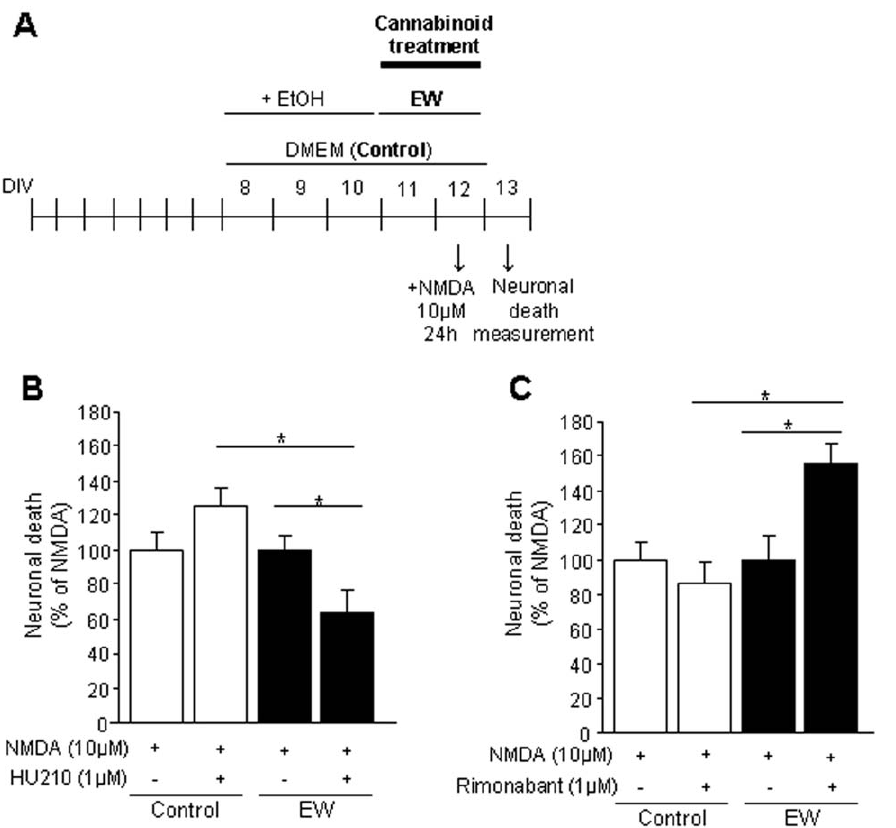
Figure 3. The acute manipulation of the endocannabinoid system influences neuronal viability during ethanol withdrawal. Effects of the acute activation or blockade of the endocannabinoid signaling on neuronal viability in control (neurons not exposed to ethanol) or ethanol– withdrawn neurons (EW). (A) Representative scheme of the experimental protocol. (B) The administration of the non-specific cannabinoid agonist HU- 210 (1 m M) during ethanol withdrawal decreases NMDA-induced neuronal death in ethanol-withdrawn neurons. Interestingly, the neuroprotective effect of HU-210 is specific of alcohol withdrawal situation, since it has no effect on control neurons. (C) The acute administration of the CB1 antagonist rimonabant (1 m M) increases NMDA-induced neuronal death in alcohol-withdrawn neurons. Again, this effect is specific of the withdrawal situation and rimonabant, when administered acutely, has no effect on control condition. Values are normalized to NMDA and are means 6 SEM (n=14–18 wells/condition; N=4 plates). Data were analyzed by the ANOVA test followed by the Fisher’s PLSD test (* P ,